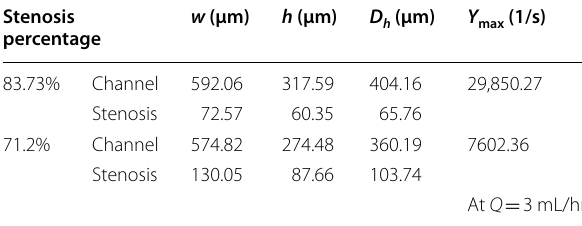
Table 1 Dimensions and maximum WSR of channels with